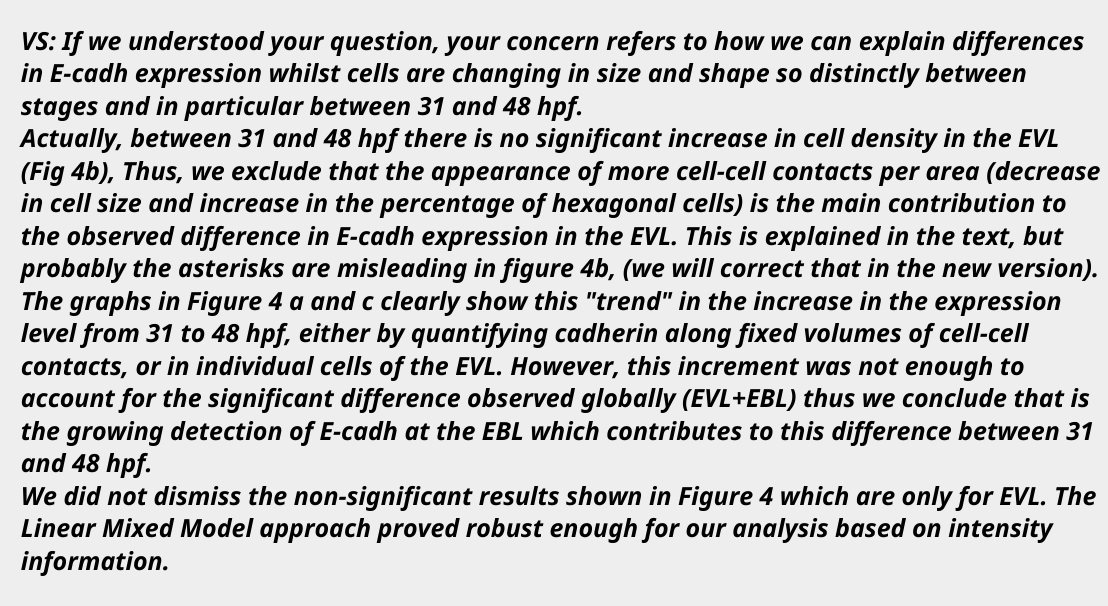
Fig. 1: what does the white arrow in Fig. 1c point to? Also, weak detection in EBL cells is not so obvious at 18hpf, maybe another arrow (head) would be helpful. VS: The white arrow indicates a single puncta adherens in contacting EVL cells. Following your suggestion, an arrowhead will point the weak detection in EBL cells at 18 hpf. Fig. 2: Comparison of E-cadh levels between stages: how far can it be excluded that immunodetection by the antibodies may be systematically different at different stages, considering the important changes in the epidermal cells, especially between 31 and 48hpf (hatching)? This comment also applies to Fig. 4, where in addition the differences between stages are either non-significant or dismissed by the